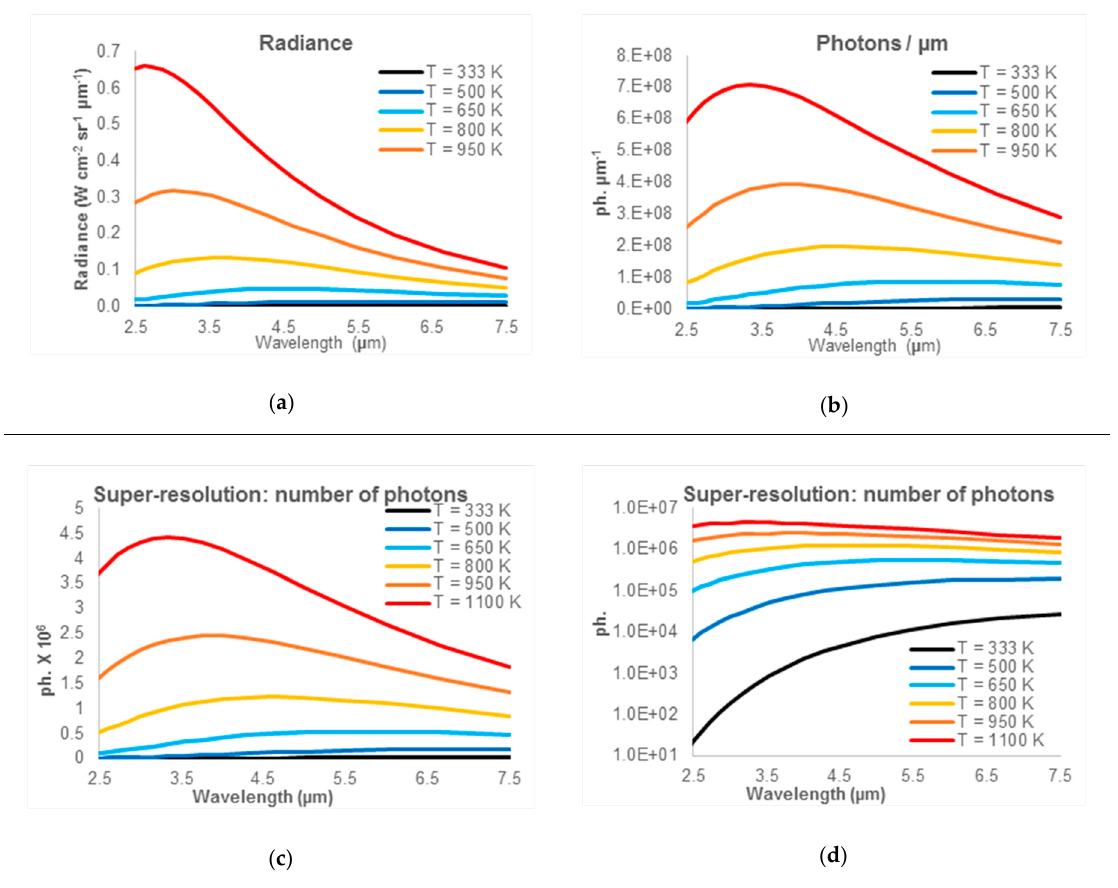
Figure 3. Super-resolution approach and data simulations. ( a ) simulated radiance emitted by a blackbody; ( b ) corresponding number of photons/µm; ( c ) equivalent number of photon at high resolution (linear scale); ( d ) equivalent number of photons at high resolution (logarithmic